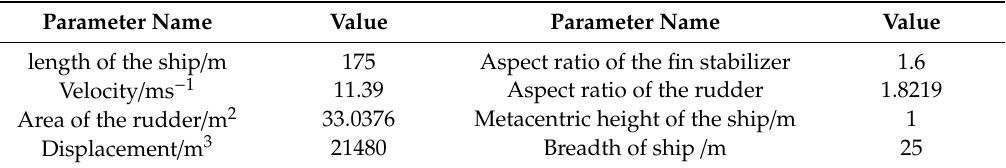
Table 1. Relevant parameters of the term vessel.